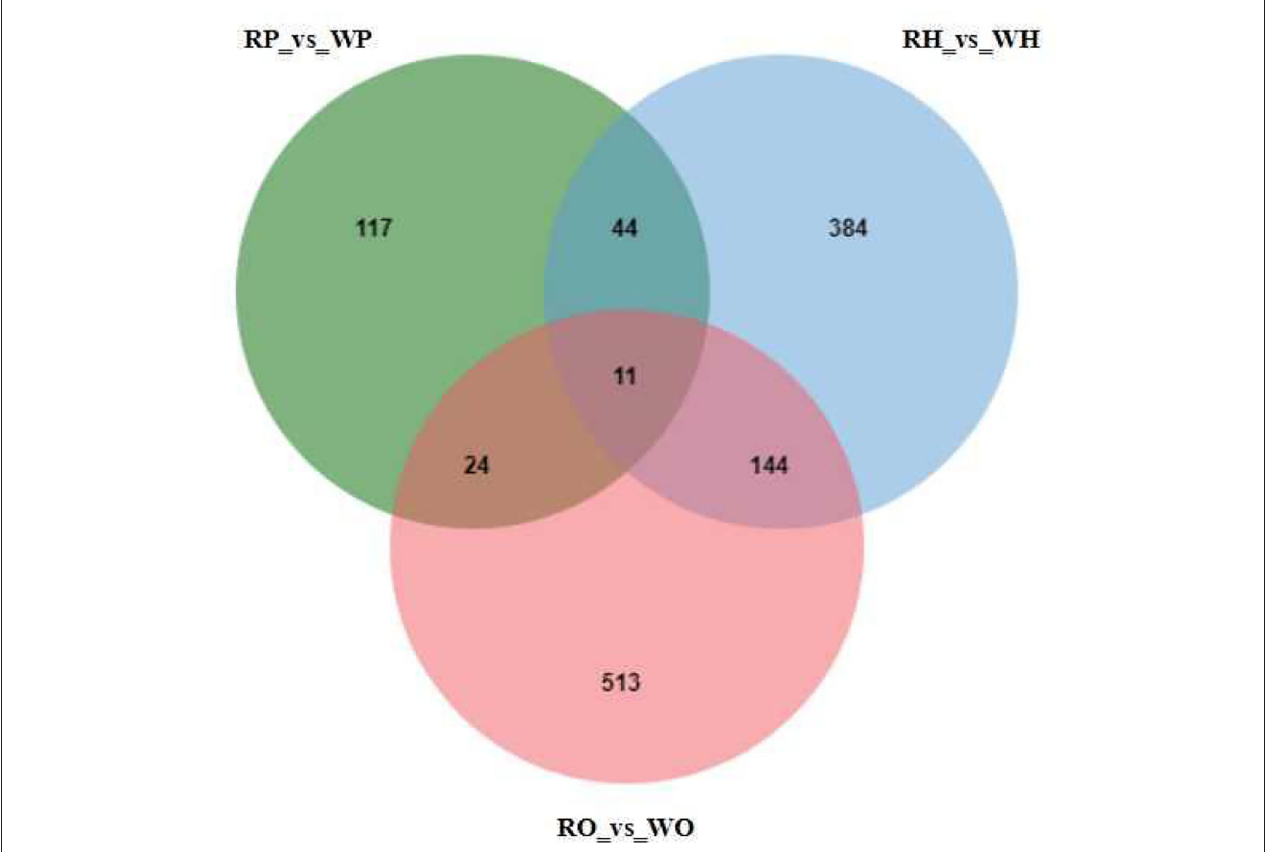
FIGURE 2 | Mutual and specific differential metabolites among the difference analysis of each group.